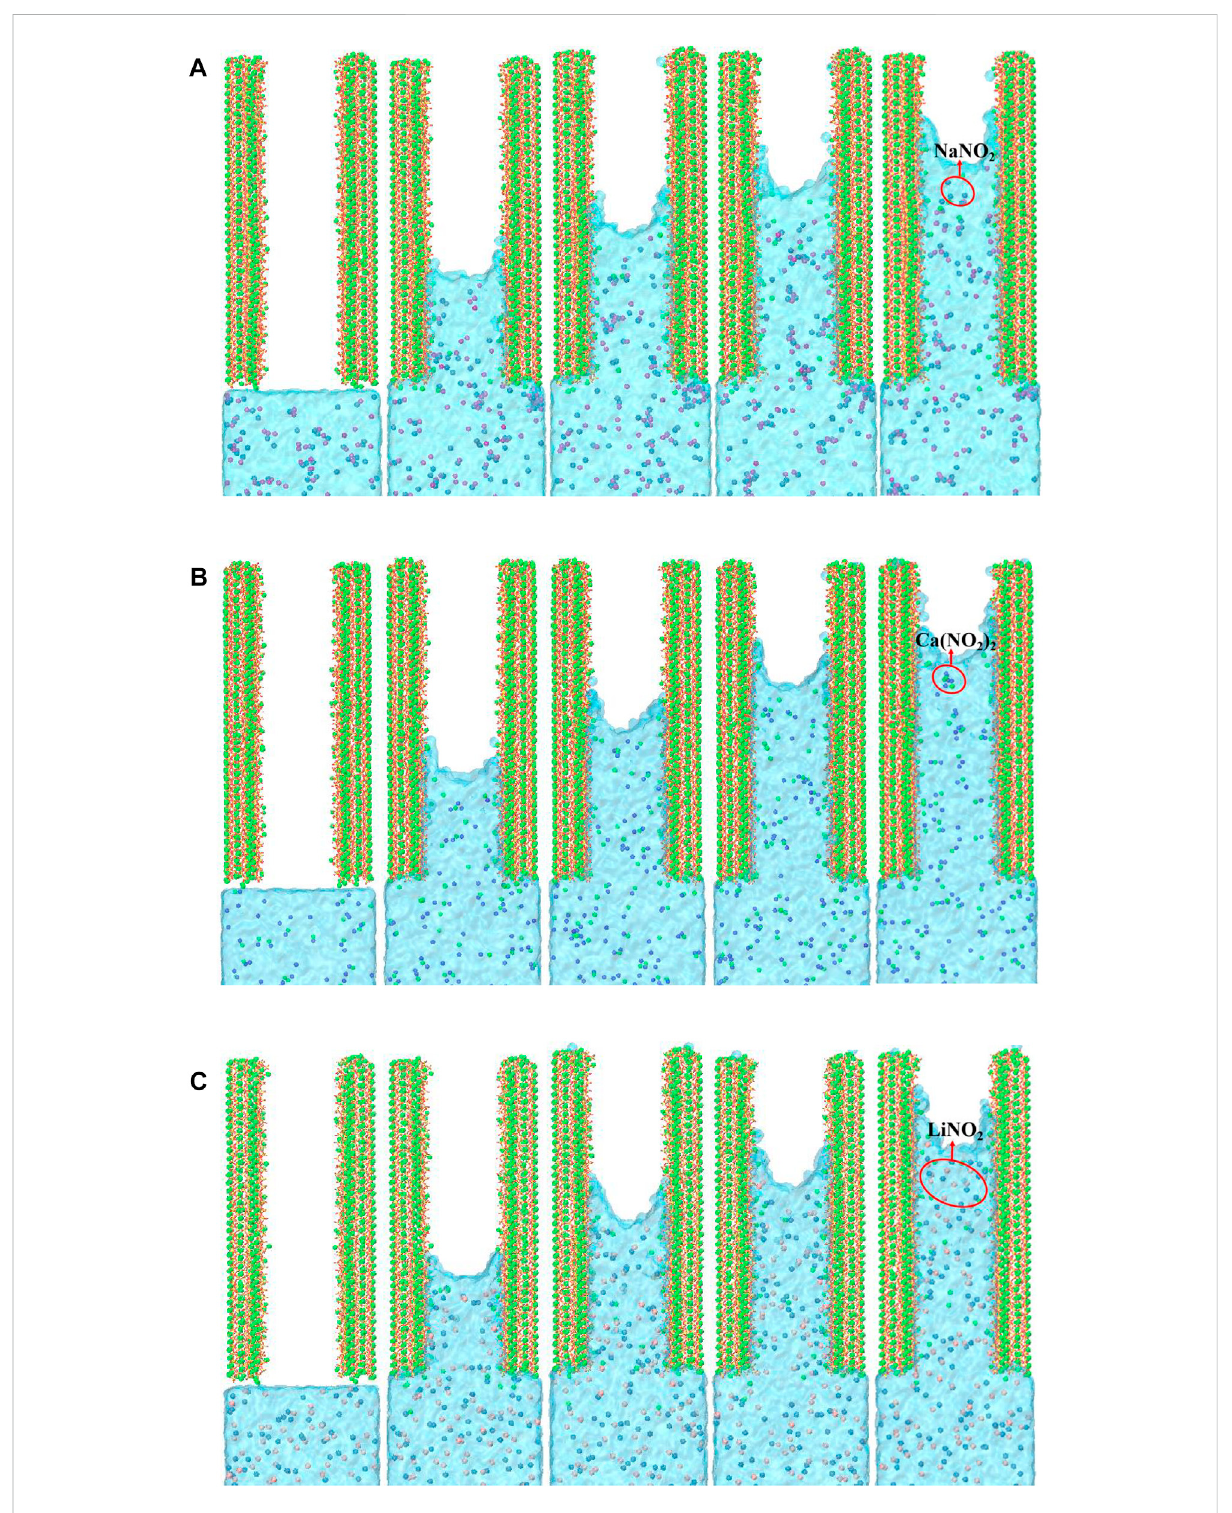
FIGURE 3 Snapshots of the water and ions transport process at 0 ps, 500 ps, 1,000 ps, 1,500 ps, and 2000 ps for (A) NaNO 2 solution, (B) Ca(NO 2 ) 2 solution, and (C) LiNO 2 solution. (Purple, green, pink and blue balls represent sodium ion, calcium ion, lithium ion and nitrate ion respectively. Besides, The green balls in (A) and (B) channel solutions are Ca ions dissolved from the CSH